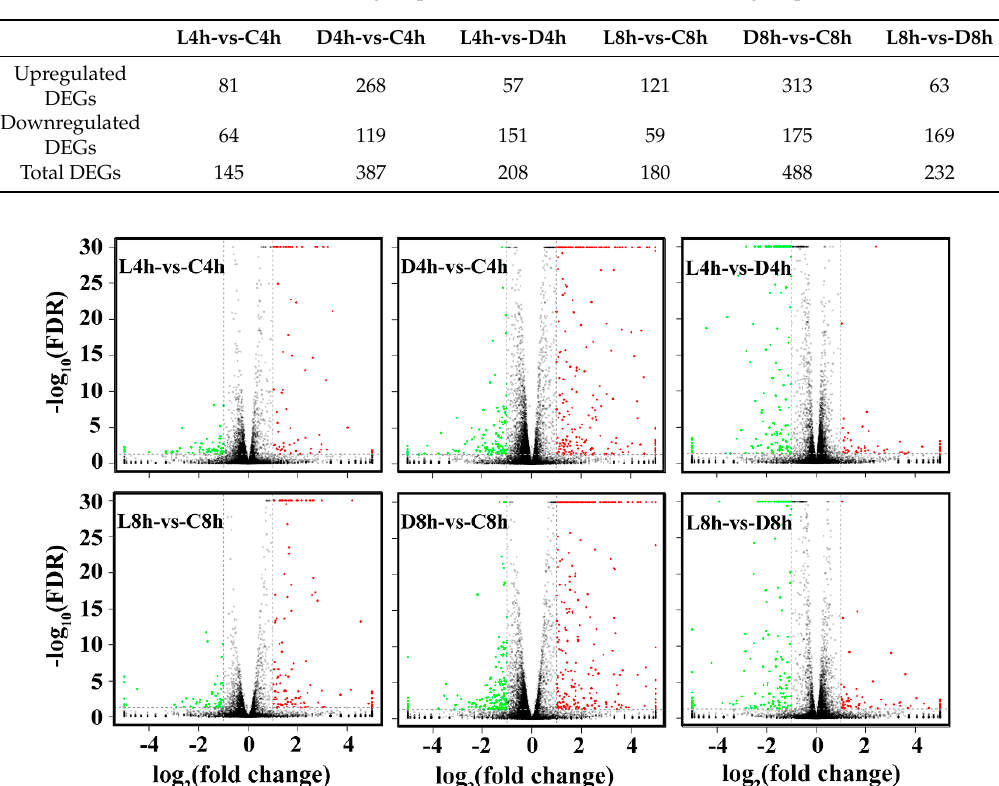
Figure 2. Volcano plot of di ff erentially expressed genes (DEGs) between di ff erent groups of Edwardsiella tarda -treated RAW264.7 cells. Red, green, and black dots represent upregulated DEGs, downregulated DEGs, and non-DEGs, respectively. The X-axis indicates the logarithm of fold change. The Y-axis displays the negative logarithm to the base 30 of the t-test Q-values. C: control groups, D: dead E. tarda -treated groups, L: live E. tarda -treated groups; 4 h: 4 hpi; 8 h: 8